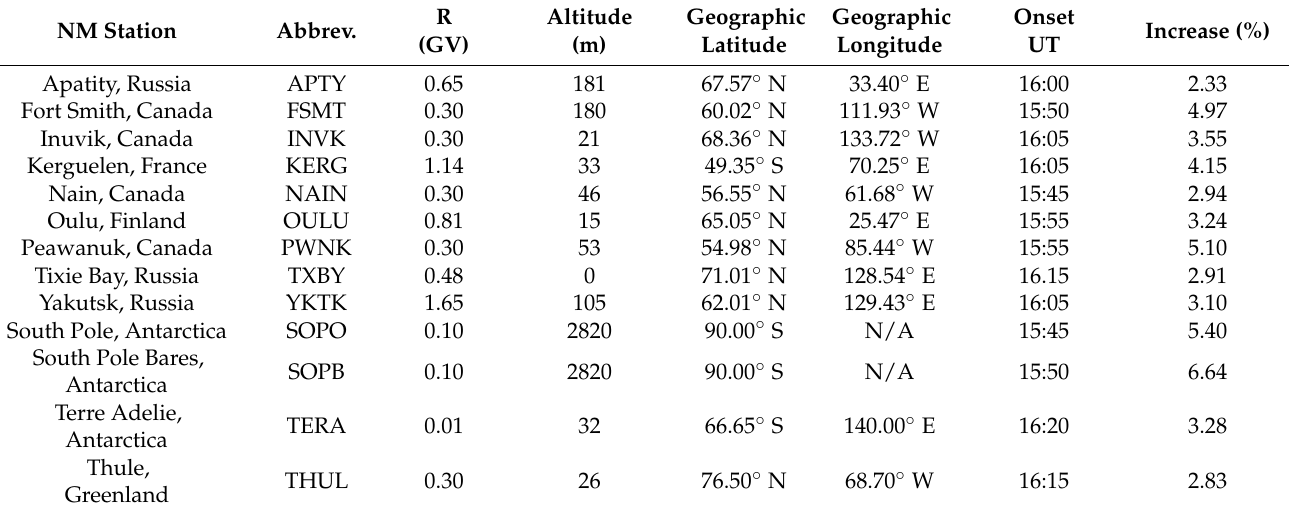
Figure 3. ( a ) A map of the NMs that recorded GLE73 (the ones that gave a GLE Alert from ANeMoS in blue) and ( b ) the perfect increase in the cosmic ray intensity as recorded by these NMs from 28 October, 14:00 UT to 29 October, 00:00 UT. Table 1. The thirteen NM stations that recorded